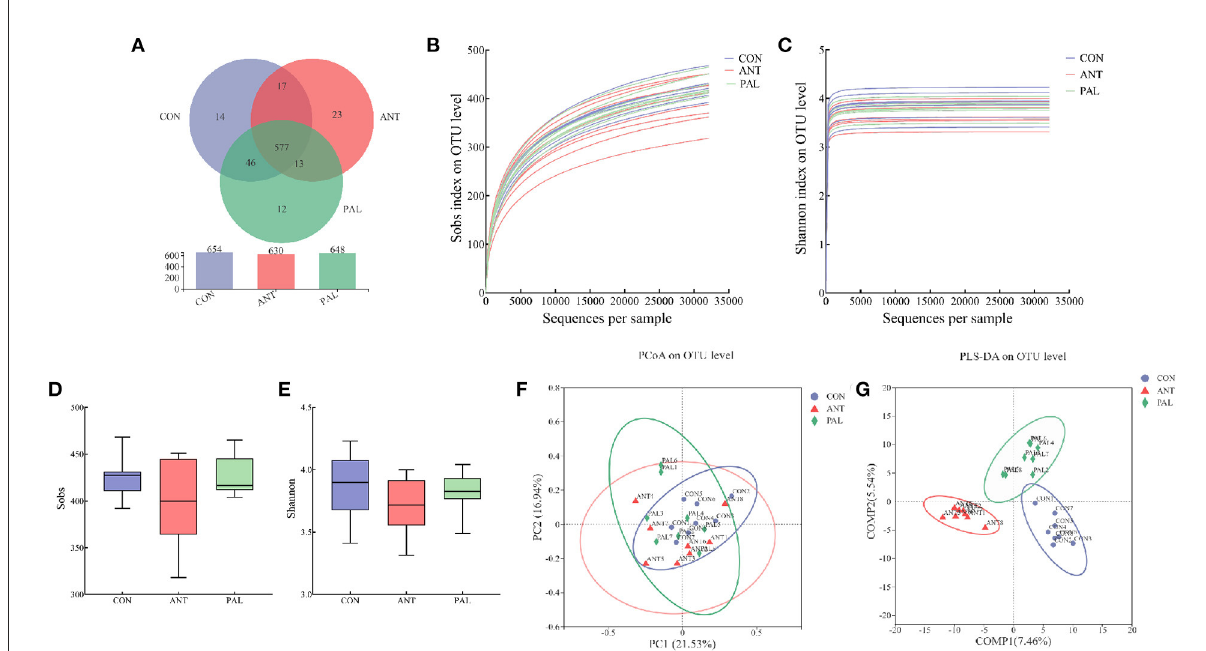
FIGURE1 Effects of dietary palygorskite supplementation on the bacterial diversity of cecal content in broilers. (A) VENN diagram of bacterial OTU; (B,C) rarefaction curves based on observed richness [Sobs, (A) ] and Shannon diversity index (B) ; (D,E) alpha diversity indexes of Sobs (D) and Shannon (E) ; (F,G) principal coordinates analysis [PCoA, (F) ] and partial least squares discriminant analysis [PLS-DA, (G) ] on OTU level, and the ellipse represents 95% confidence; CON, basal diet; ANT, basal diet supplemented with 50 mg/kg chlorotetracycline; PAL, basal diet supplemented with 10 g/kg